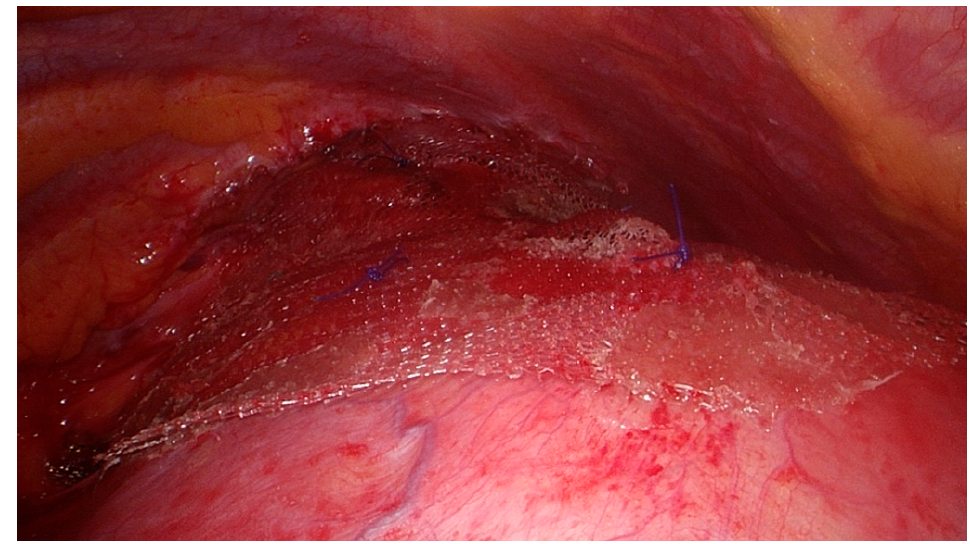
Figure 5. Application of the polyvinylidene fluoride (PVDF) mesh (DynaMesh ® -IPOM) anchored with four Prolene 2-0 stitches and surgical glue (IFABOND ® ).